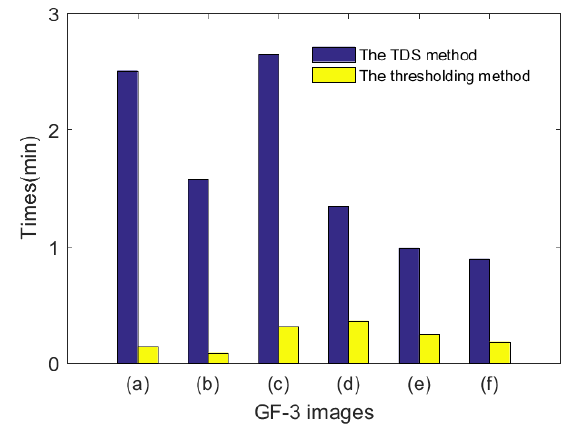
Figure 9. Computation efficiency of the TDS method and the thresholding